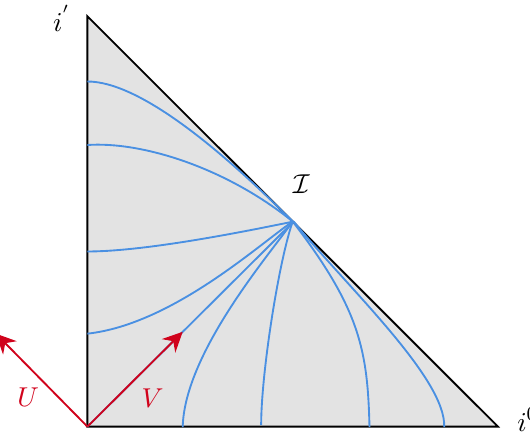
Figure 1 . Toric Penrose diagram for signature (2 , 2) Klein space. 45 o lines are null as usual. A Lorentzian torus is fibered over every point in the diagram. The spacelike cycle of the torus degenerates along the timelike line U = V , while the timelike cycle degenerates along the spacelike line U = − V . Neither cycle degenerates at null infinity I which is the interval − π Spacelike infinity i 0 is at ( U, V ) = ( − π AdS 3 / Z . Timelike infinity i 0 is at ( U, V ) = ( π (2 , 1) AdS 3 / Z . The blue lines are lines of constant w ¯ w − z ¯ z with τ = 0 at U = 0